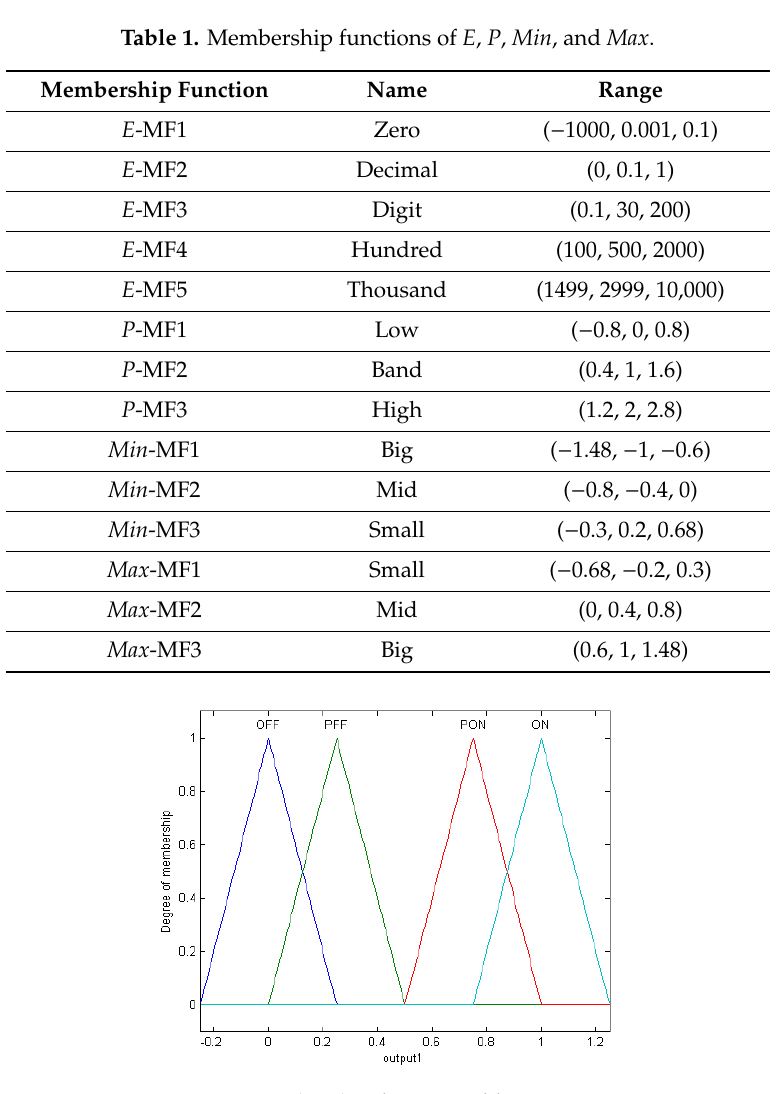
Figure 5. Membership function of fuzzy output. Table 2. Membership functions of fuzzy output (POFF and PON means probably o ff and probably Table 1. Membership functions of E , P , Min , and Max .